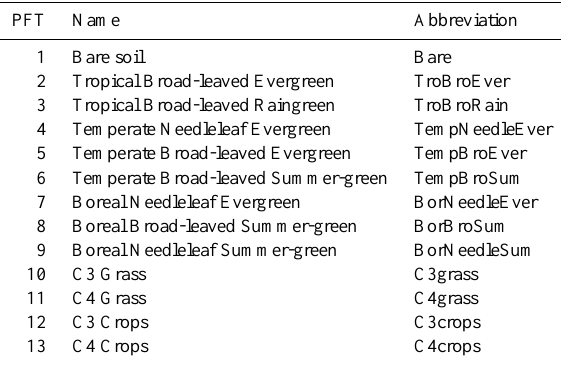
Vegetation types and their abbreviations as used in